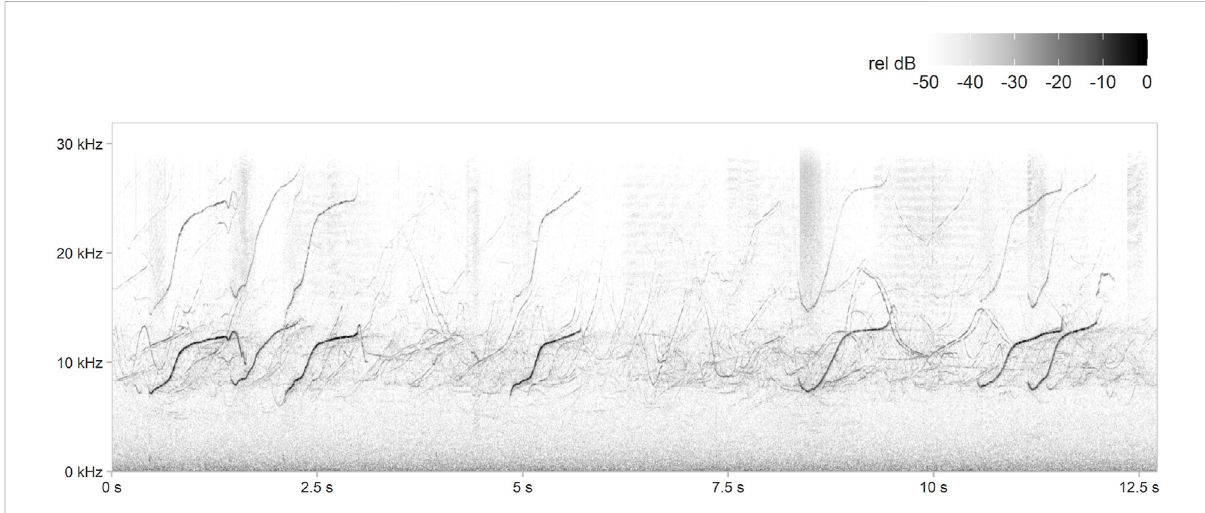
FIGURE 3 Example spectrogram of dolphin whistles and echolocation clicks detected during this study. Spectrogram parameters: fast Fourier transform (FFT) size = 1,024 points, overlap = 95%, sample rate = 64,000 Hz, frequency resolution = 62.5 Hz and time resolution = 0.8